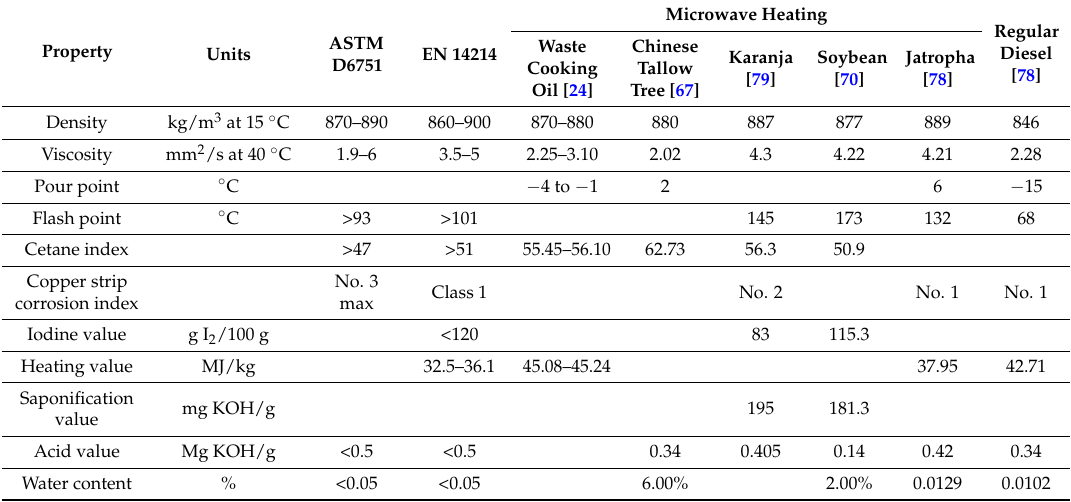
Table 7. Microwave-based biodiesel